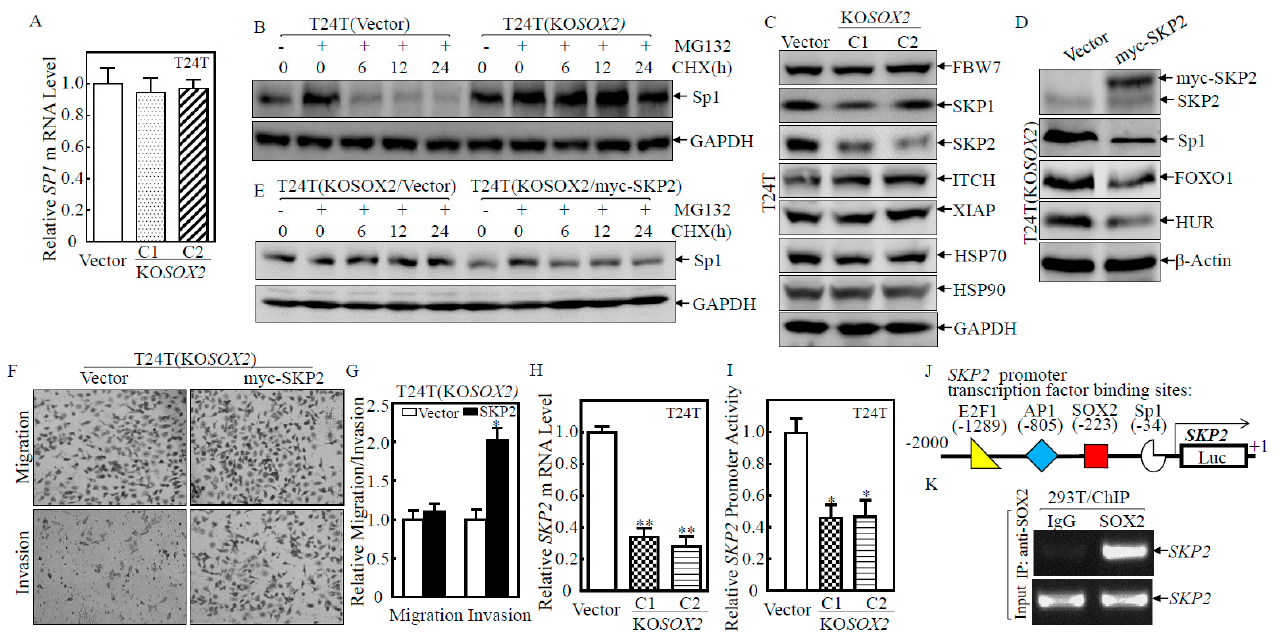
Figure 5. SKP2 mediated the invasion of BC cells by promoting the degradation of the Sp1 protein. ( A ) Real-time PCR was applied to compare the Sp1 mRNA levels in T24T(Vector) and T24T(KO SOX2 C1/C2) cells. ( B , E ). The indicated cells were pretreated with MG132 and the